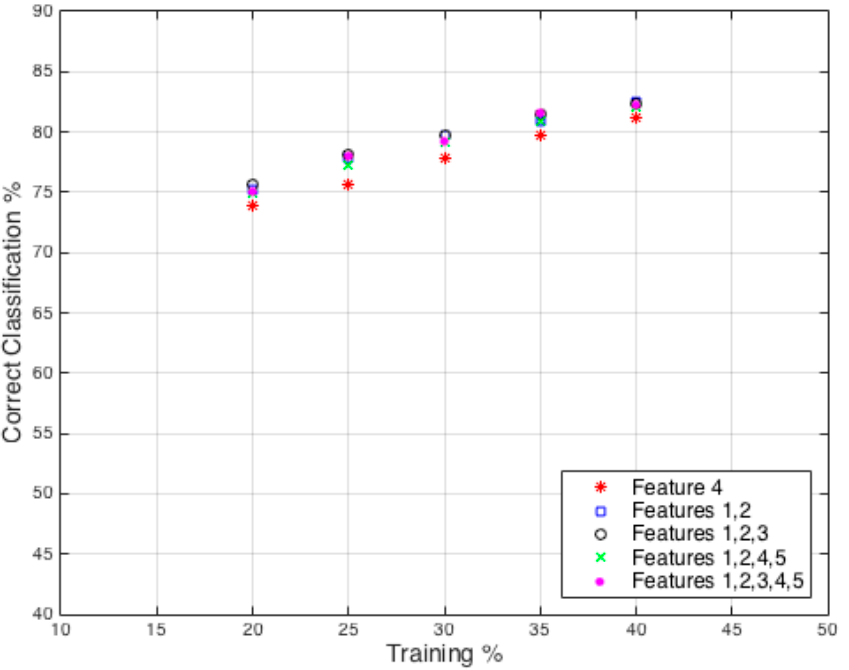
Figure 12. Data from all individuals: Random Forest Classification accuracy plotted against percentage of training set size used.